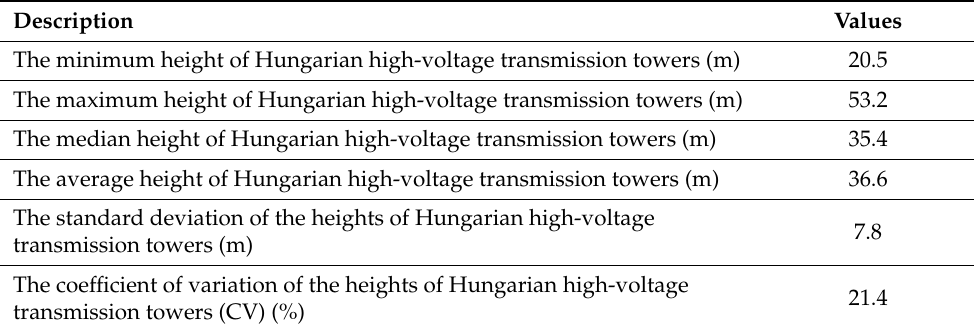
Table 4. The height characteristics of Hungarian high-voltage transmission towers.